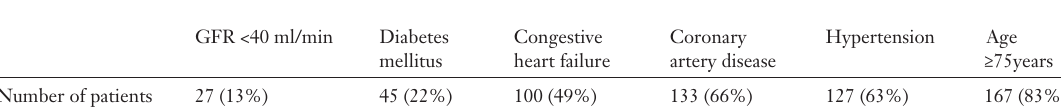
Incidence of risk factors for contrast- medium-induced nephropathy in 202 patients undergoing TAVI at Saint Paul’s Hospital, Vancouver, BC,